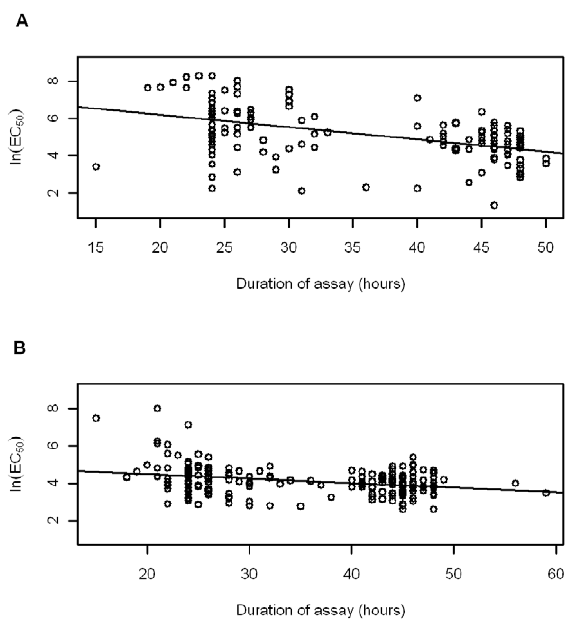
Figure 2. Relationship between the proportion of ring stage parasites at start of assay (0 hours) and ln(EC 50 ). The figure depicts relationships for (A) P. vivax and (B) P. falciparum .